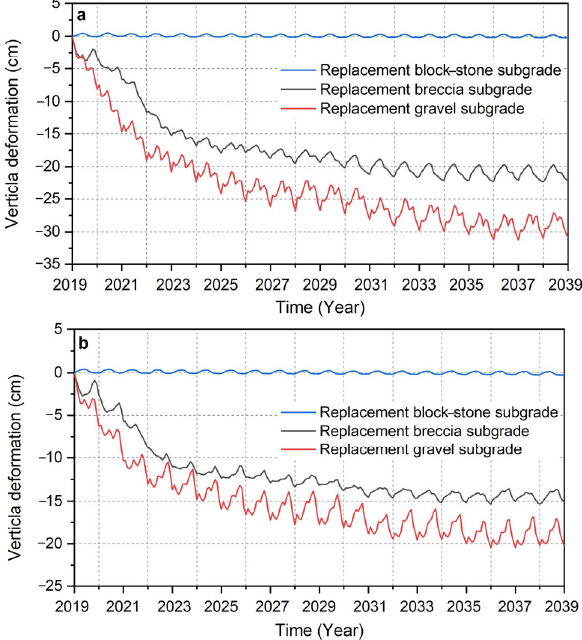
Figure 16. Vertical deformation curves at the road centerline and the shoulder of the three subgrade structures in Case 1: ( a ) at the road centerline and ( b ) at the shoulder.